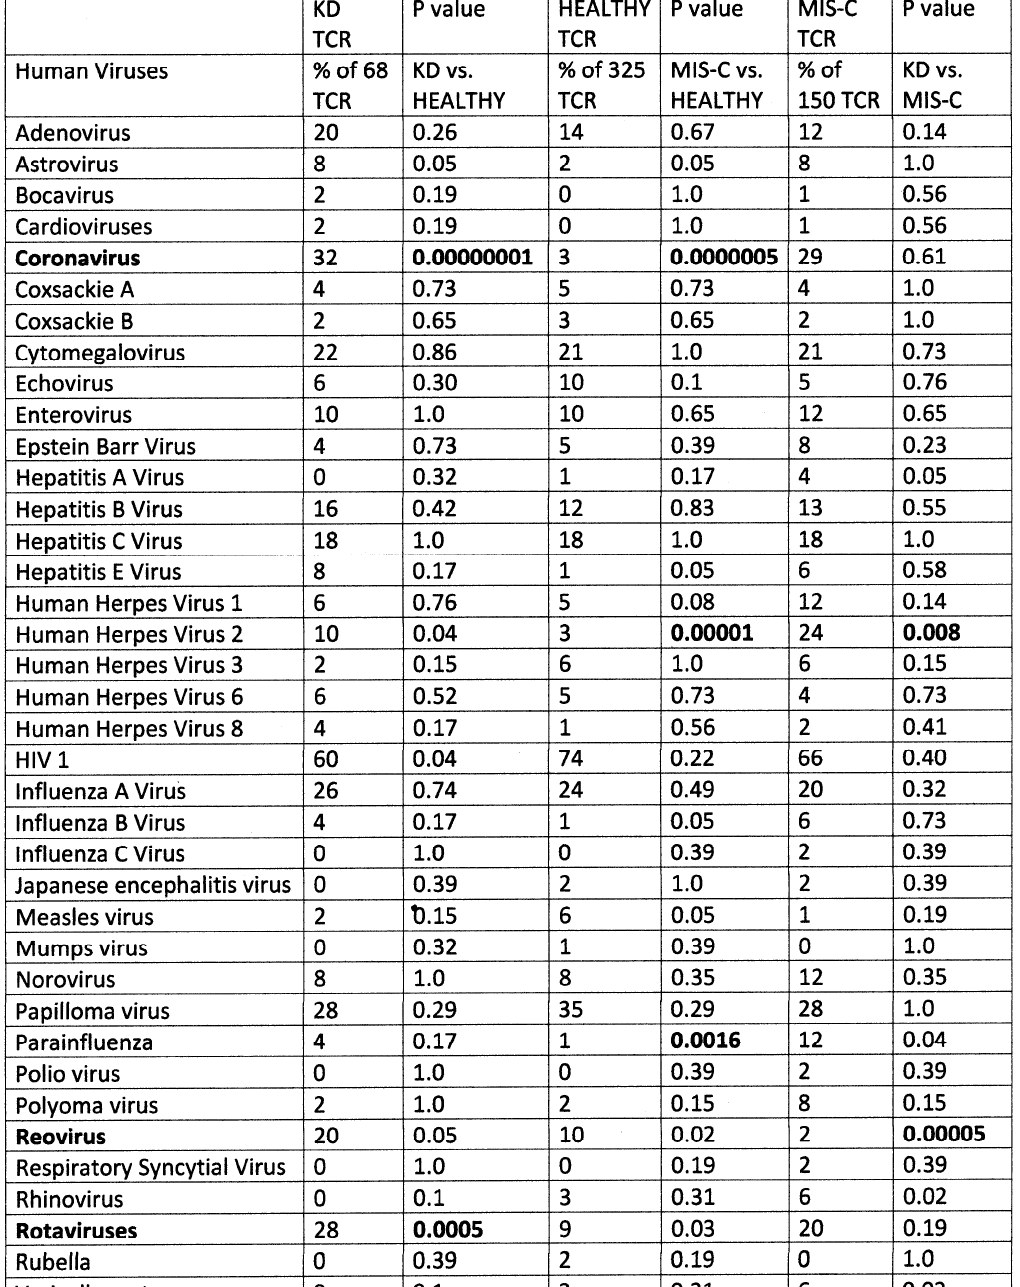
Figure 5. Summary of frequency (by percentage of TCRs tested) of TCR sequence similarities for Kawasaki disease (KD) patients, healthy individuals, and multisystem inflammatory syndrome in children (MIS-C) patients to virus proteins that may be targets of autoimmunity in these diseases. The statistical significance of differences between each pairing was determined by chi-squared analysis providing a p value. However, because each TCR was analyzed against every virus, a Bonferroni correction was required to interpret the resulting p values such that to reach a significance of p < 0.05 after the correction, the chi-squared value must be 0.002 or less. Values less than 0.002 or